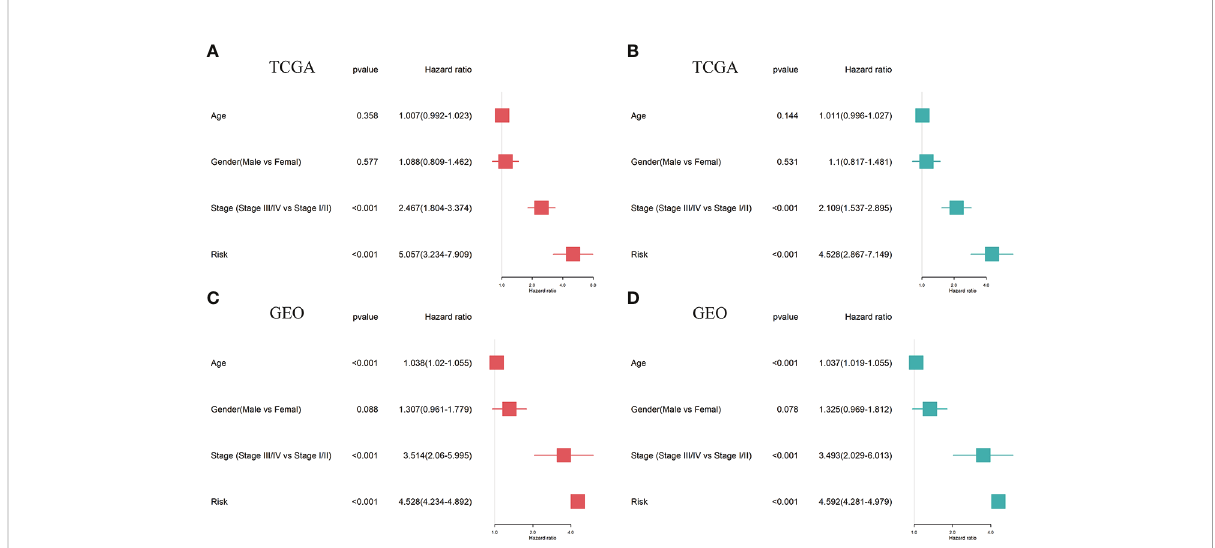
FIGURE 5 Ability of a risk score and clinical factors to predict the prognosis of LUAD patients. (A, B) Univariate (A) and multivariate (B) Cox regression analyses were used to analyze correlations between OS and other clinical variables, including risk scores in the TCGA database. (C, D) Univariate (C) and multivariate (D) Cox regression analyses were performed to analyze the associations between OS and various clinical variables, including risk scores in the GEO